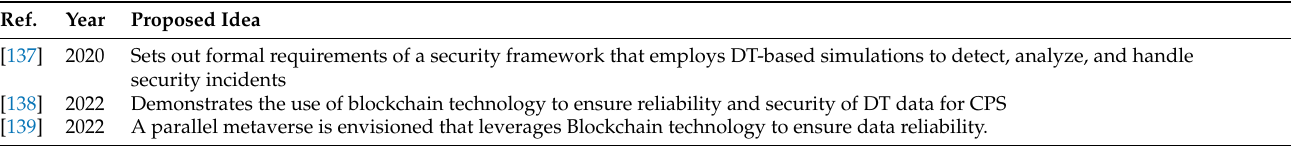
Table 7. Applications in Security of Cyber-Physical systems.